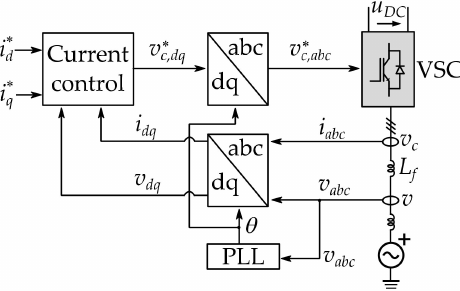
Figure 3. Voltage-oriented control (VOC) based on the measurement of the grid voltage angle through a PLL. MG: Microgrid, VSC: Voltage Source